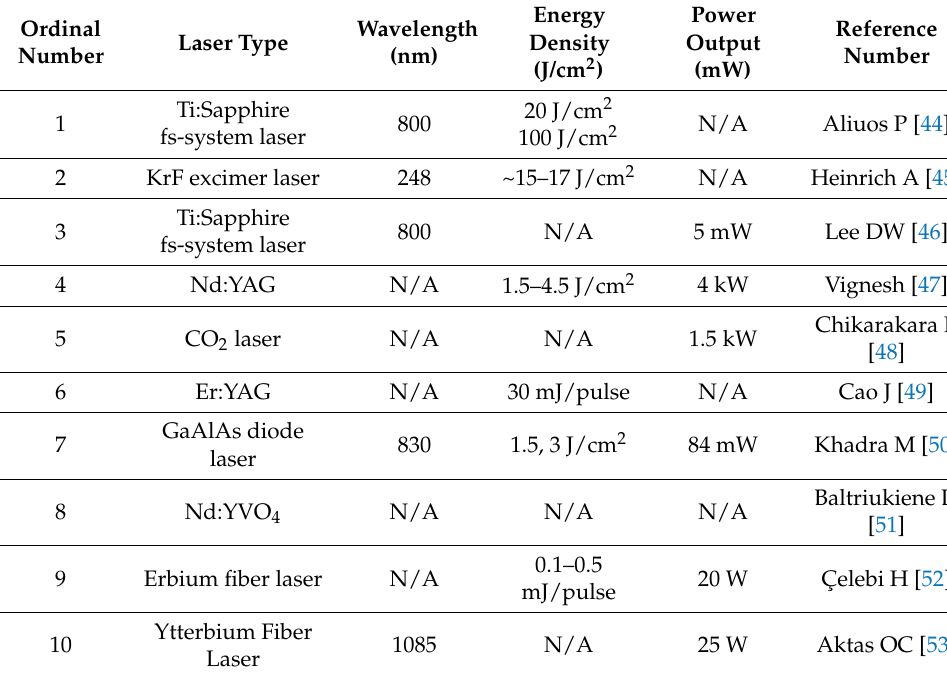
Table 4. Characteristics of lasers used for